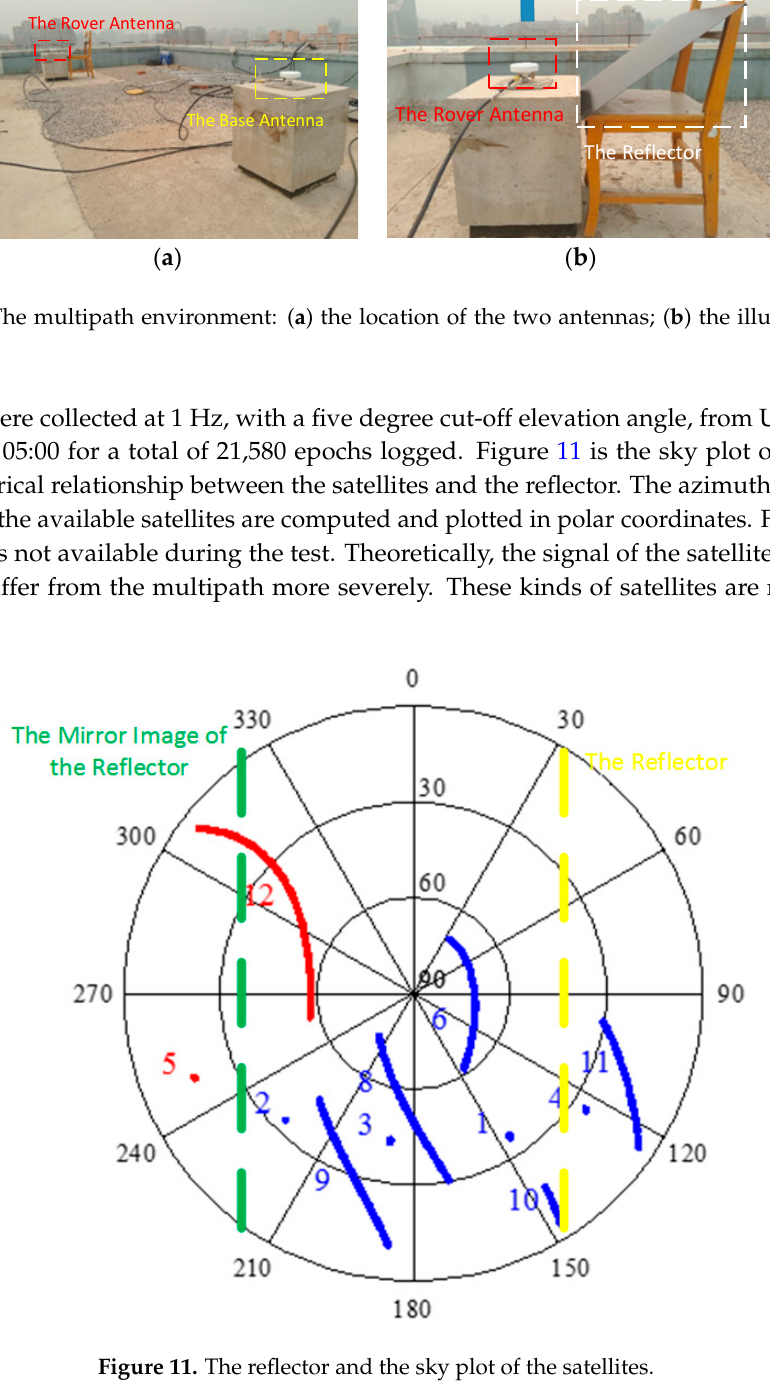
Figure 11. The reflector and the sky plot of the